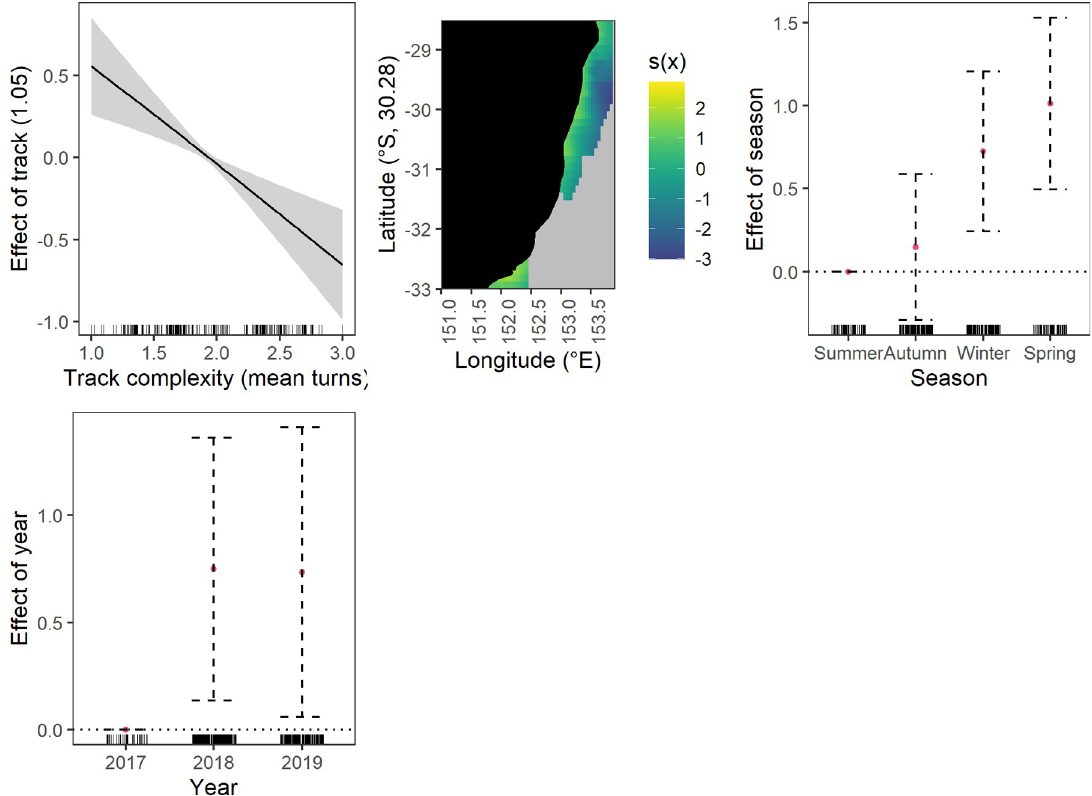
Fig 2. Significant effects plots from the discarded elasmobranchs response generalised additive mixed models, shaded area represents the 95% confidence limits whilst the surfaces represent the effect of 2-d smoothing on spatial coordinates.